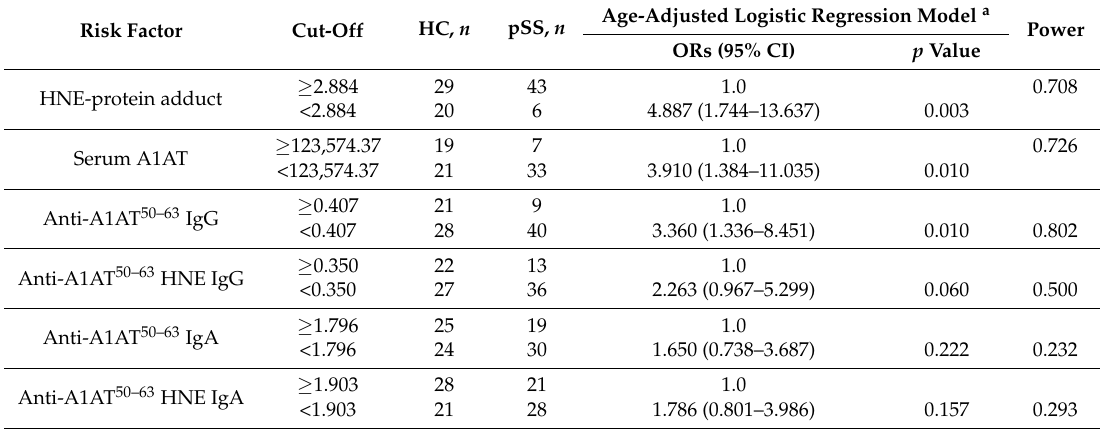
Table 2. Association among HNE-protein adduct, A1AT, anti-A1AT 50–63 and their HNE-modified peptides antibodies and pSS patients, in patients with pSS vs. healthy